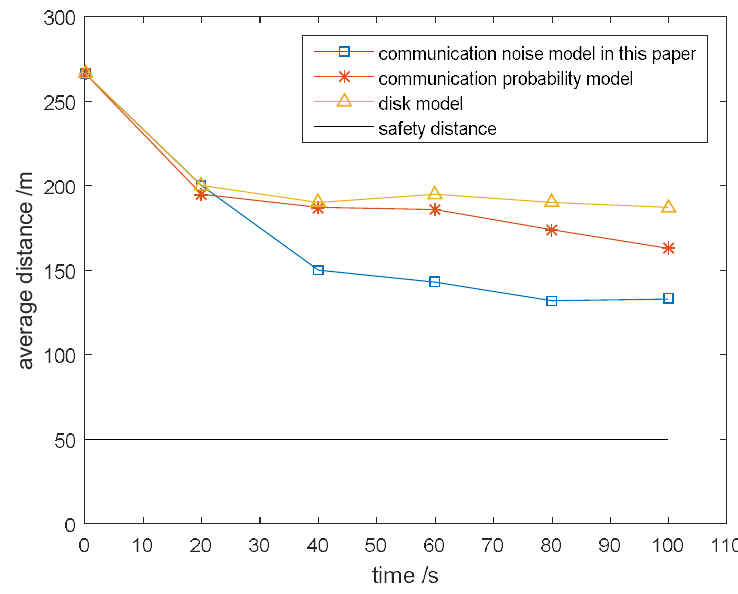
Figure 9. The average distance between UAVs compared with other methods.